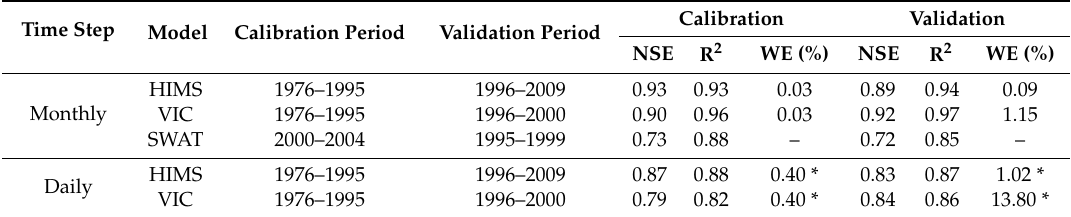
Table 9. Statistical comparison with the observed streamflow and the streamflow simulated with the HIMS, VIC, SWAT model at monthly time